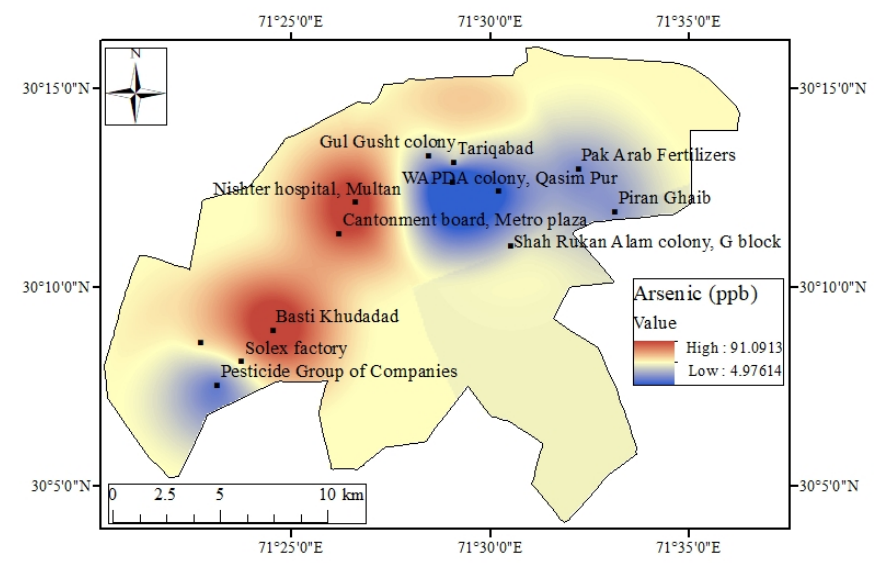
Figure 14. Spatial variability in arsenic